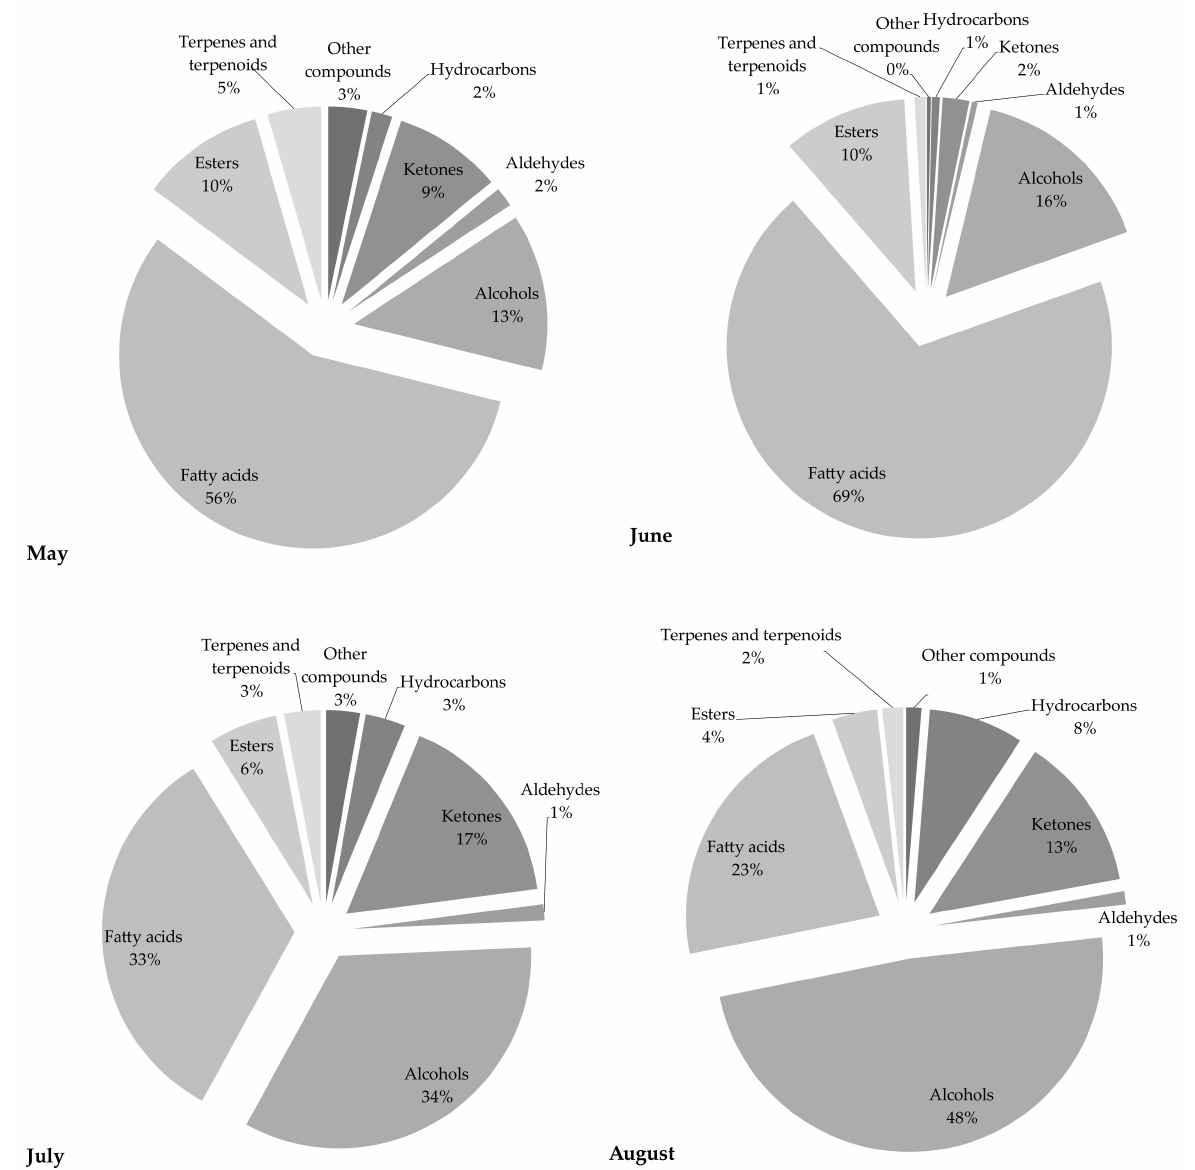
Figure 1. The relative content of each chemical class of compounds detected in C. compressa